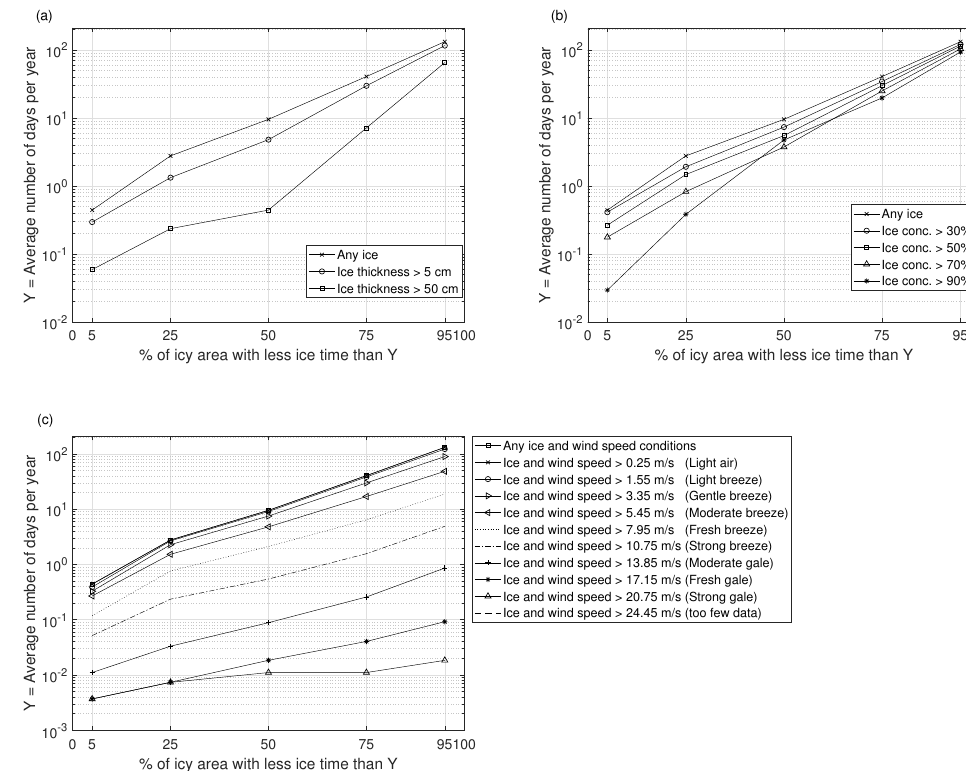
Figure 4. Percentile values for the average number of days per year with regards to selected ice thickness classes (in ( a )), ice concentration (conc.) classes (in ( b )), and wind speed classes during ice conditions (in ( c )). The wind speed classes were created based on an adapted Beaufort scale [57], and ice concentration classes were based on the WMO sea-ice classes [71], while ice thickness categories were created for every 5 cm; however, only selected lines corresponding to the lowest and thickest considered ice classes are shown here to increase the clarity of the